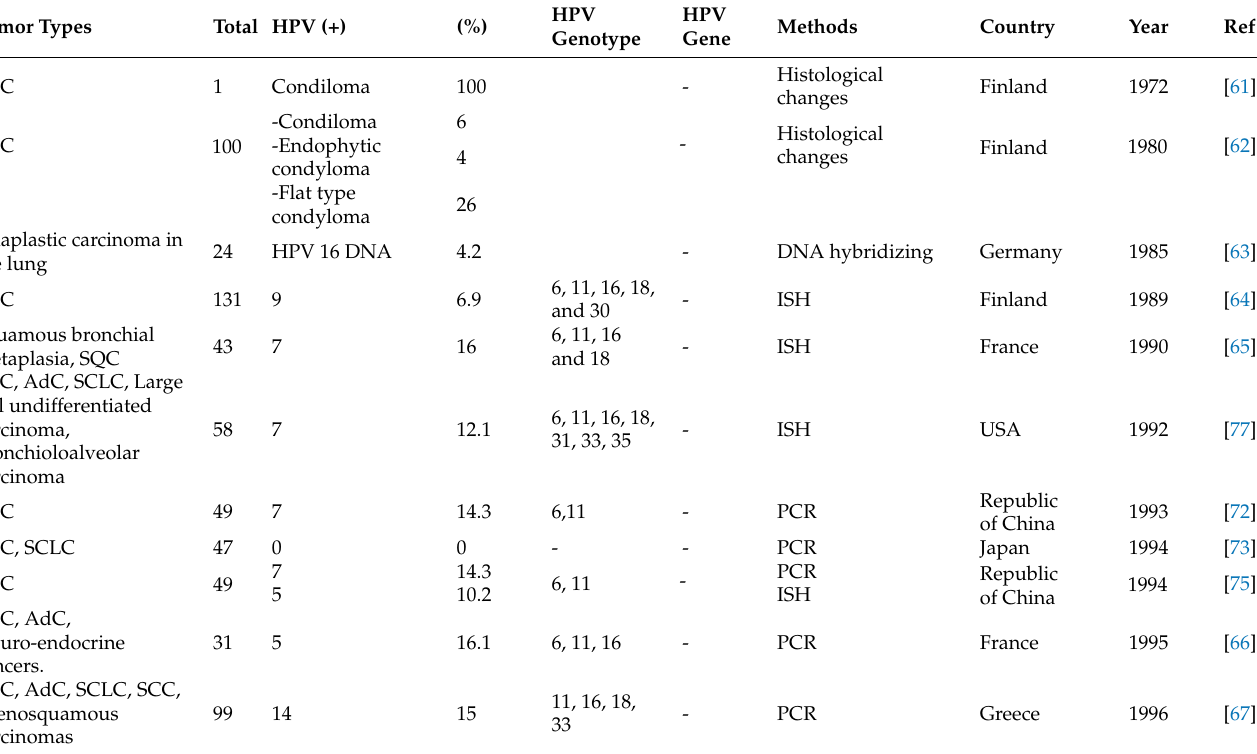
Table 1. HPV frequency in lung cancer